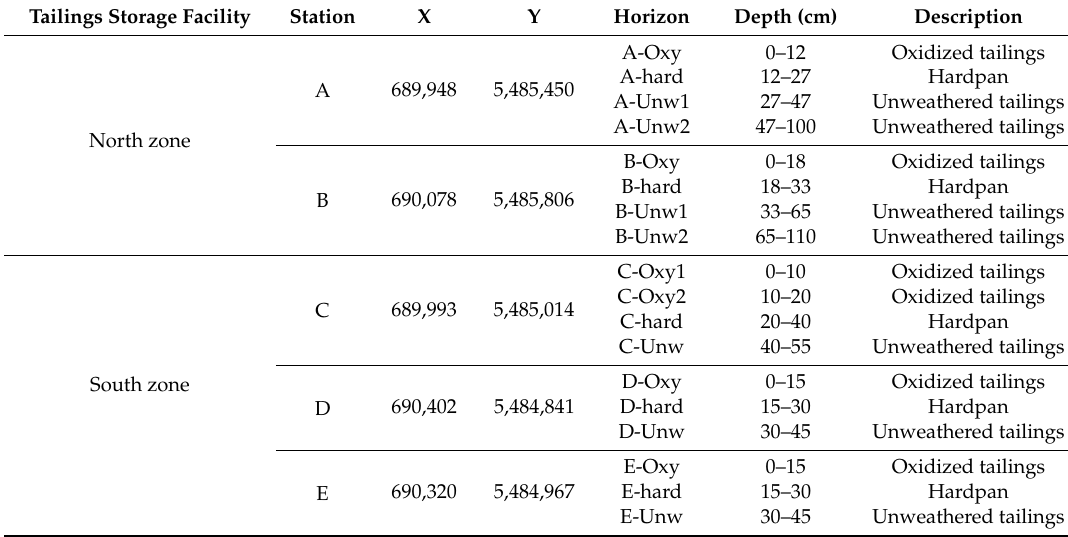
Table 1. Description of the samples collected for the mineralogical characterization using